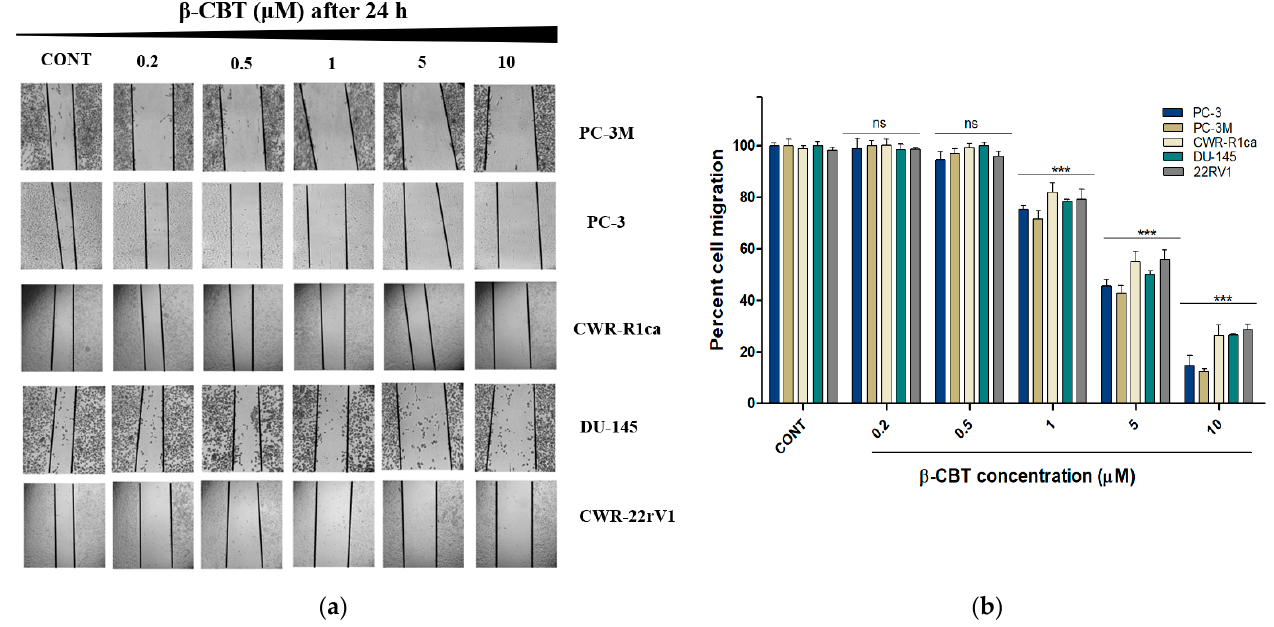
Figure 2. Effects of β -CBT treatments on the migration of PC-3M, PC-3, CWR-R1ca, DU-145, and CWR-22rv1 PC cell lines. ( a ) Representative microscopic photographs of wounds in different PC cell monolayers after 24 h incubation with control and β -CBT treatment at different concentrations (0.2–10 μ M). ( b ) Dose–response of different β -CBT concentrations on percent cell migration of treated PC cell lines. Bar graphs represent mean percent cell migration (± SD) at the indicated β -CBT concentration relative to vehicle-treated control cells (CONT, 100% migration). *** indicates statistical significance relative to the control cells at p < 0.001, and “ns” indicates statistical non-significance at p < 0.05.